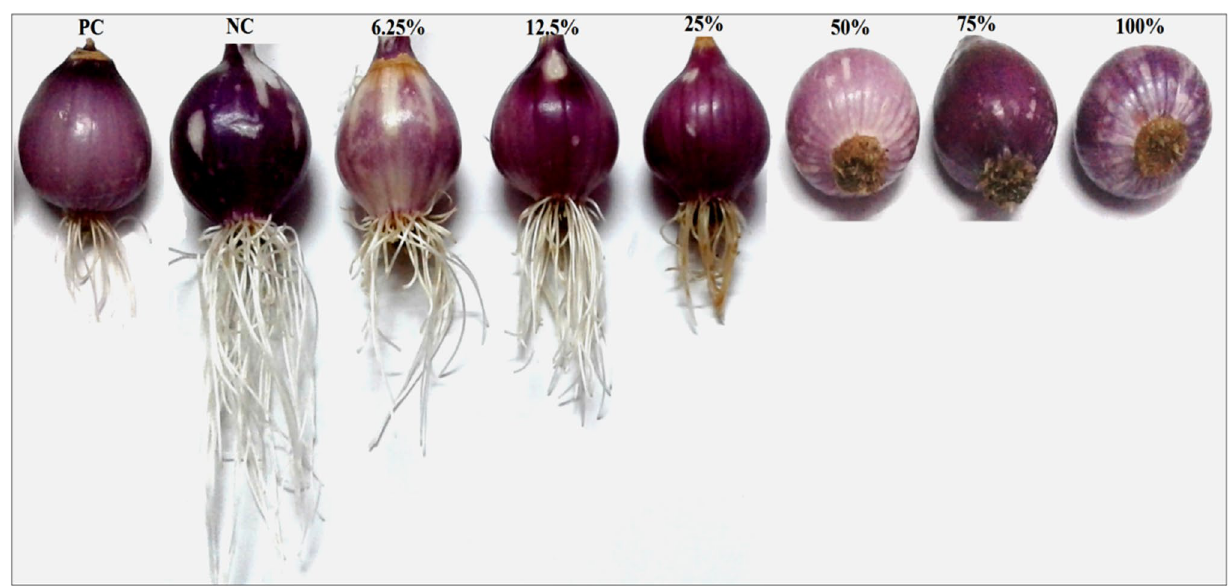
Fig. 3 PC positive control (EMS-5 mM), NC negative control (tap water), and 6.25%, 12.5%, and 25% refer to treatments with different concen- trations of pharmaceutical effluent Table 2 Indices of chromosomal abnormalities observed in the root tip cells of onions grown in different concentrations of pharmaceutical effluent